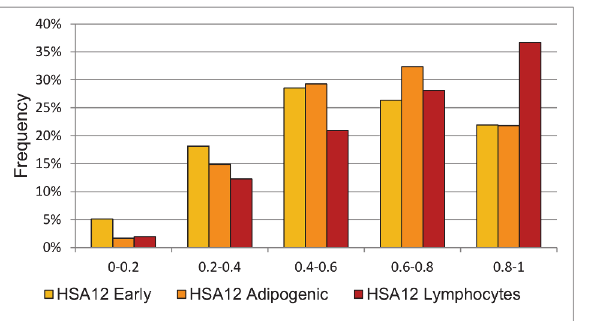
Fig 7. RDCs of HSA12 in MSC at early passages, after adipogenic differentiation and in lymphocytes. RDCs of HSA12 differ between MSC cells at early passages, after adipogenic differentiation (p = 0,008) and lymphocytes (p < 10 – 9